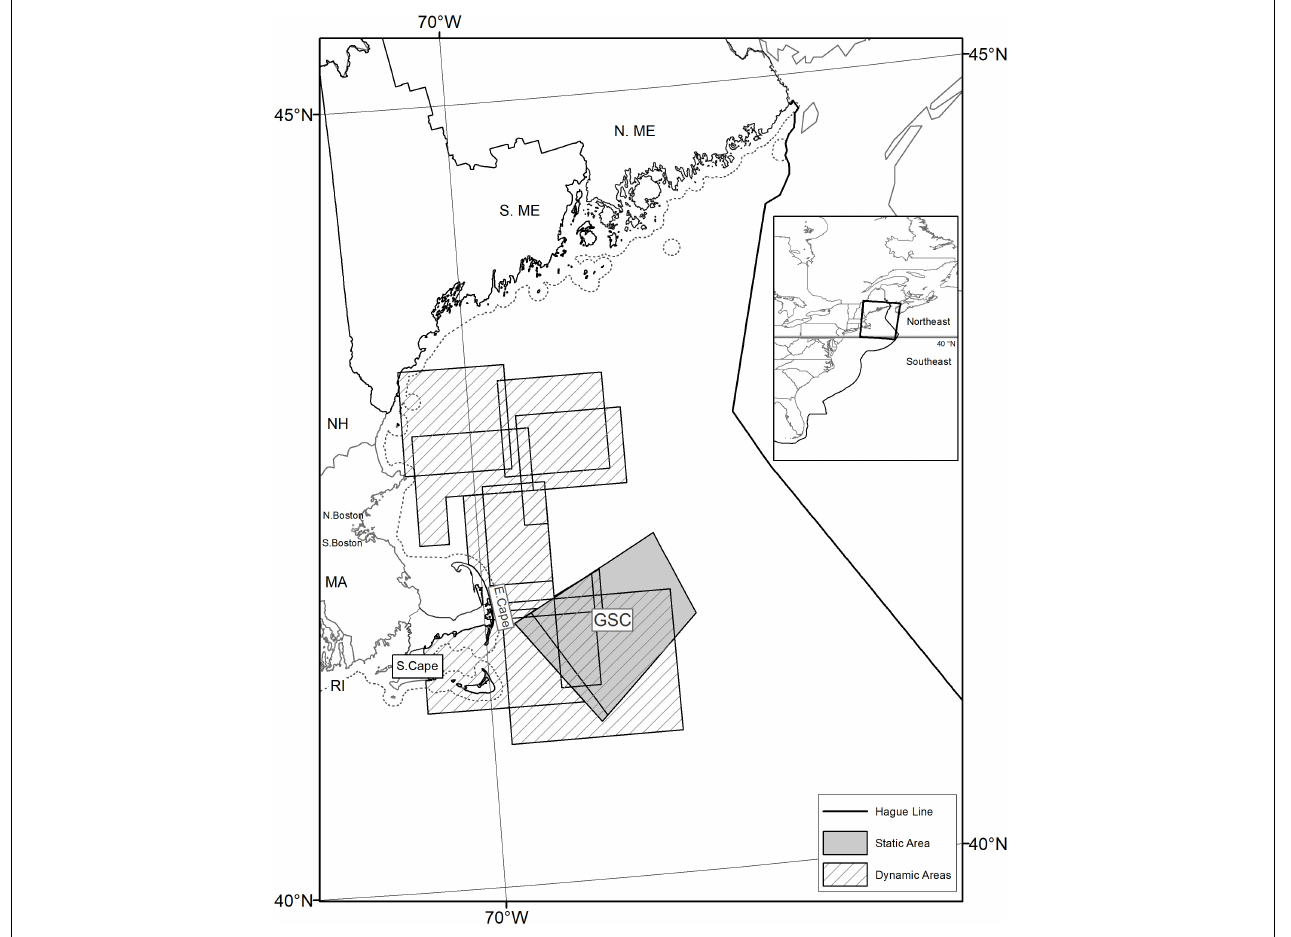
FIGURE 2 | Right whale management areas in the northeast United States that required removal of lobster fishing gear during certain times of year (i.e., avoid risk), as identified in the Atlantic Large Whale Take Recovery Plan, 2002–2009, with port groups and state waters (dash line 3 nm from shore) identified. Great South Channel (GSC) critical habitat area (solid gray area), and Dynamic Area Management (DAM) zones (hatched